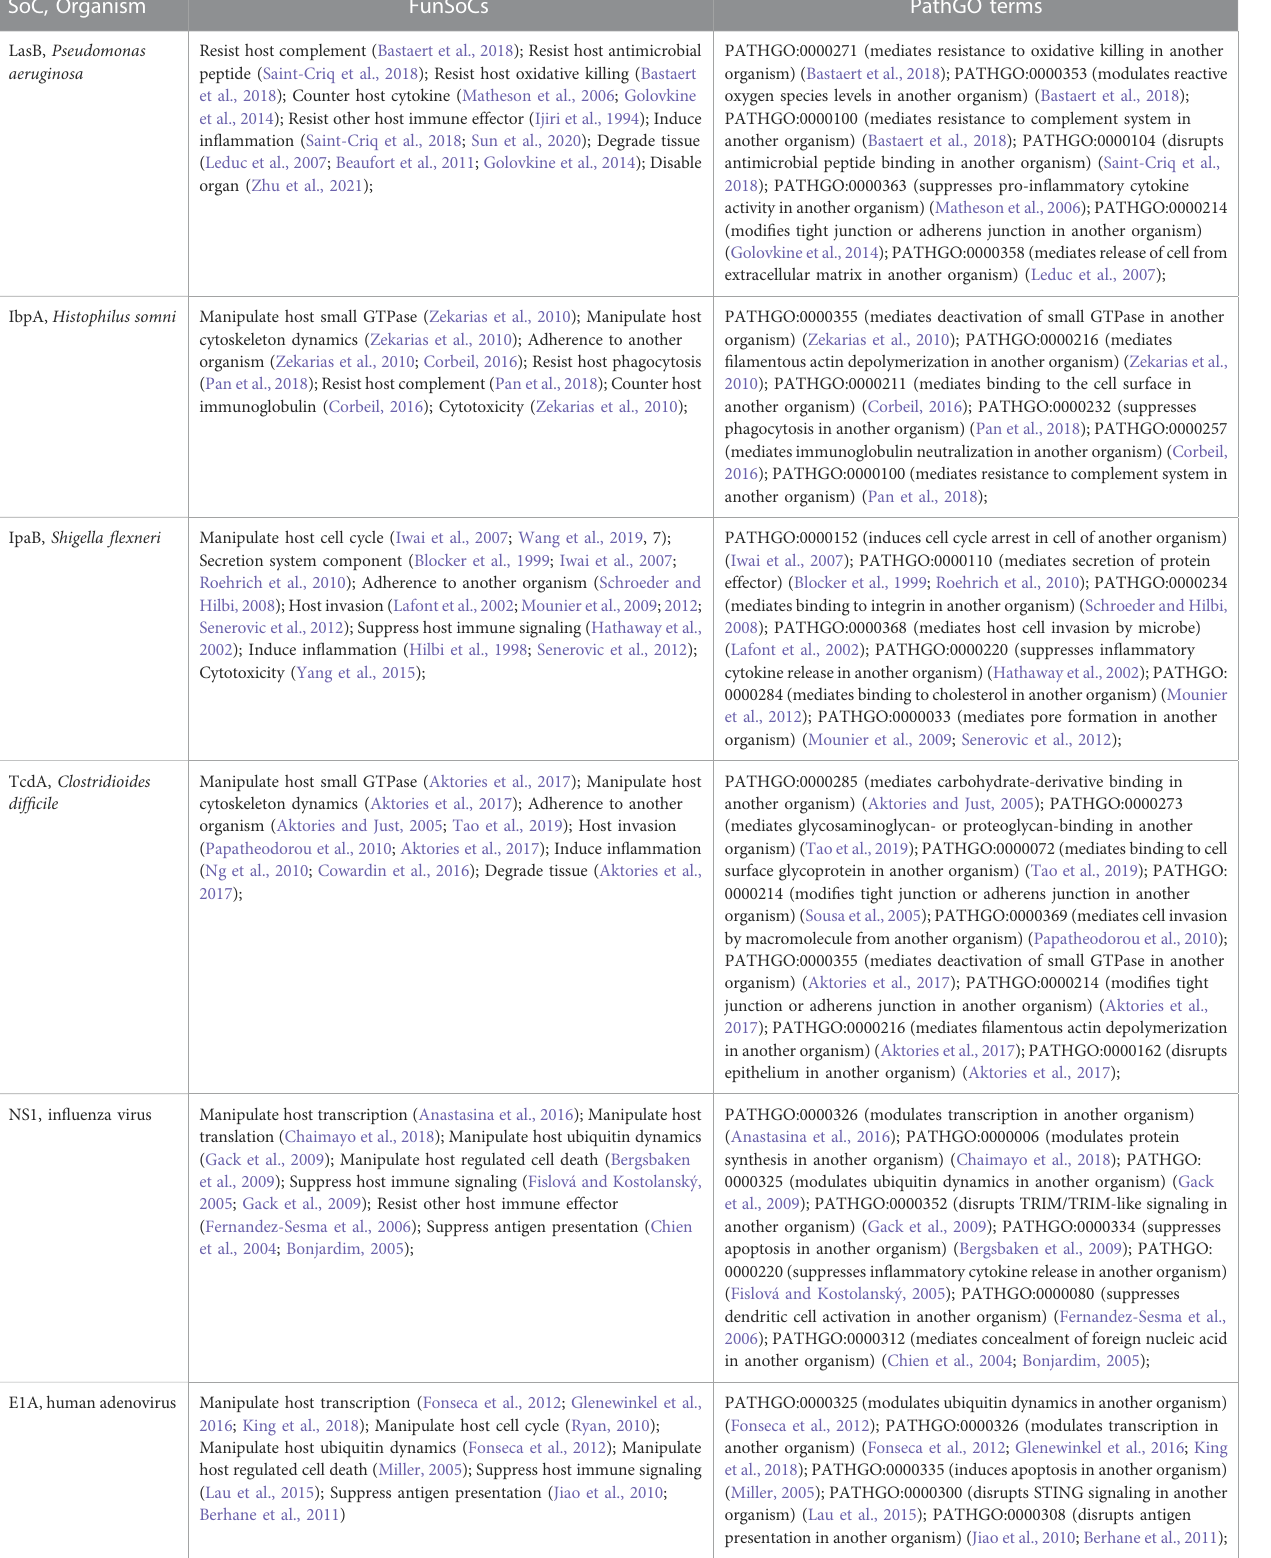
TABLE 5 SoCs with multiple functions from bacterial, viral, and eukaryotic